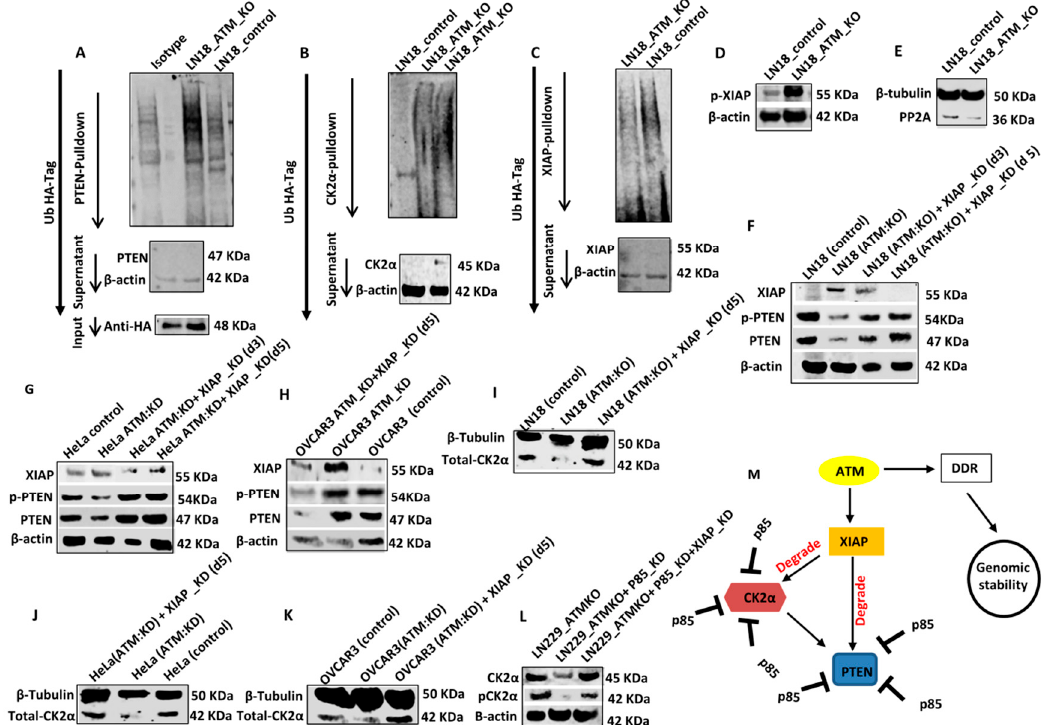
Figure 4. XIAP E3-Ubiquitin ligase and ATM mediated PTEN degradation. ( A ) PTEN IP was blotted on SDS-PAGE gel against HA antibody. ( B ) CK2 IP was blotted on SDS-PAGE against HA antibody. ( C ) XIAP IP was blotted on SDS-PAGE against HA antibody. ( D ) p-XIAP levels in LN18, LN229 control, and ATM KO. ( E ) Levels of PP2A by western blot in LN18 and LN229 control and ATM_KO ( F ). LN18 ATM KO cells were transfected with XIAP SiRNA. Levels of PTEN, p-PTEN and XIAP were analysed by western blot on day3 and day5. ( G ) Hela ATM _KD cells were transfected with XIAP SiRNA. Levels of PTEN, p-PTEN and XIAP were analysed by western blot on day3 and day5. ( H ) Levels of PTEN, p-PTEN and XIAP in OVCAR3 cells transfected with ATM SiRNA alone or ATM SiRNA and XIAP SiRNA Simultaneously. ( I ) LN18 ATM KO was transfected with XIAP SiRNA. On day5 levels of CK2 α were analysed. ( J ) Hela ATM _KD cells were transfected with XIAP SiRNA. On day5 levels of CK2 α were analysed. ( K ) OVCAR3 cells were transfected with ATM SiRNA and XIAP SiRNA simultaneously. On day5 levels of CK2 α were analysed. ( L ) LN229 ATM KO cells were transfected with p85 SiRNA alone or p85 SiRNA and XIAP SiRNA simultaneously. Levels of CK2 α and p-CK2 α were analysed on day5. All data are representative of 3 independent experiments. Where appropriate, quantification is summarized in Supplementary Figure S4. ( M ) Proposed model for ATM regulated PTEN degradation.